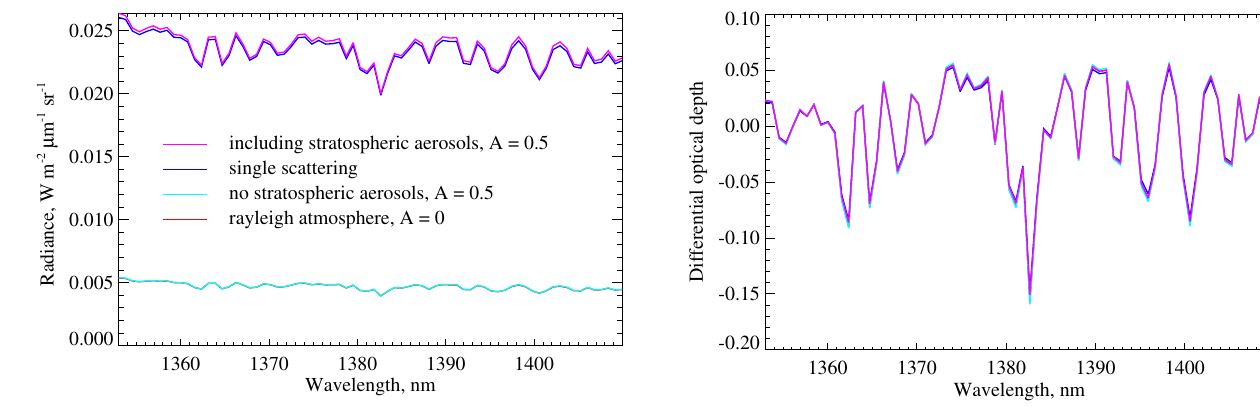
Fig. 4. Same as Fig. 3 but for differential logarithmic intensities (differential optical depths). The curves for all considered cases are very similar and barely seen below the magenta line.